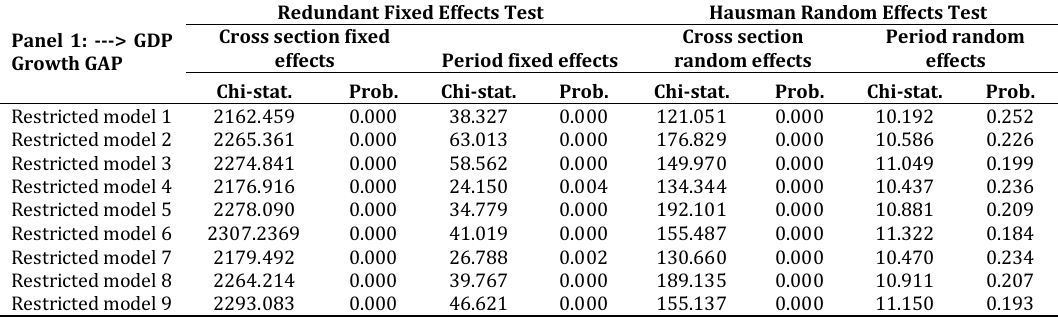
Source : own estimations based on data from World Bank Table 5: Redundant Fixed Effects Tests & Hausman Random Effects Tests – Panel 2 (dependent variable GDP per capita gap) Panel 2: ---> GDP per capita growth GAP